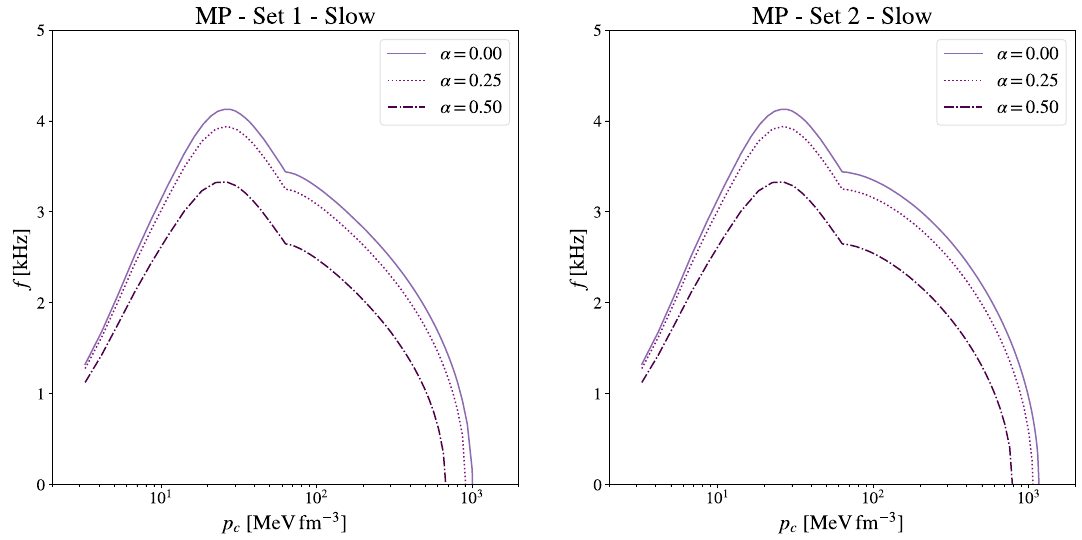
Fig. 5 Predictions for the fundamental linear eigenfrequency as a function of central pressure for charged twin stars, considering slow conversions and the Set 1 (left panel) and Set 2 (right panel) of the MP approach for the QM EoS